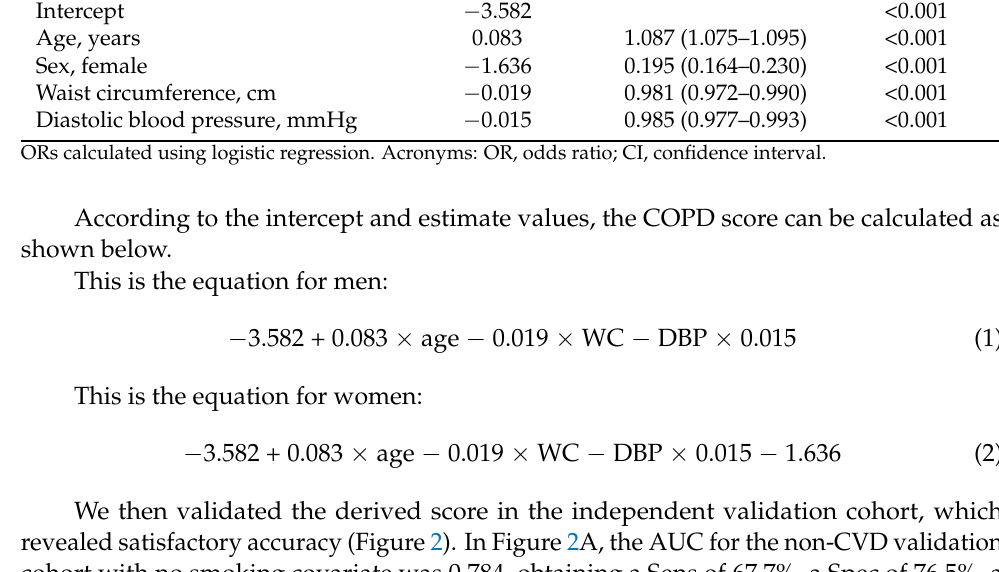
Table 3. Multivariable model for prediction of COPD in the training cohort. Covariate